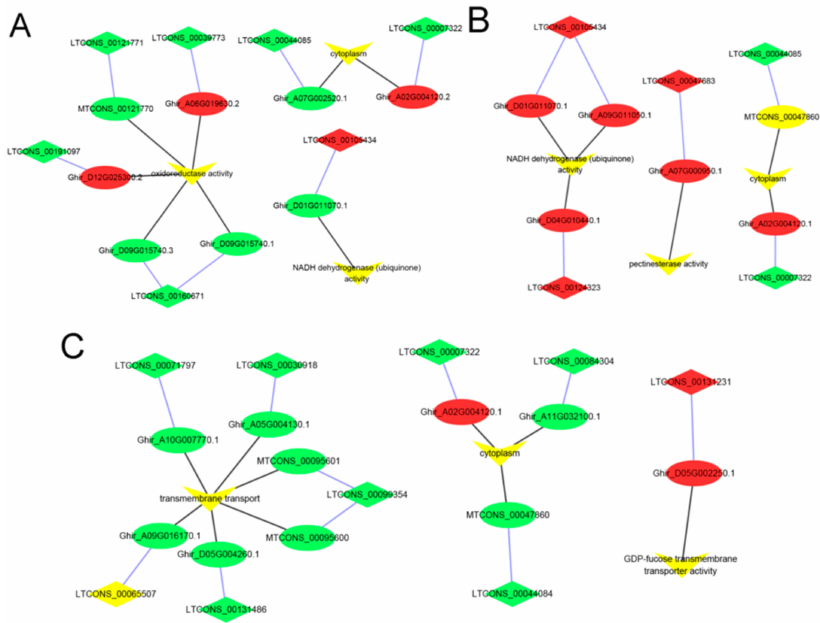
Figure 5. GO analysis enriched for lncRNA–potential cis -target genes of anther development between the cytoplasmic male sterility line C2P5A, and the maintainer line C2P5B. ( A ) GO terms enriched for the Pms stage lncRNAs–mRNAs. ( B ) GO terms enriched for the Tds stage lncRNAs–mRNAs. ( C ) GO terms enriched for the Ms stage lncRNAs–mRNAs. The ellipse, diamond, and inverted triangle nodes represent the mRNAs ( cis -target genes), lncRNAs, and GO terms, respectively. Red represents upregulated, green represents downregulated, and yellow represents the enrichment of the GO terms. The blue edges and black edges show regulatory interactions among cis -target genes and lncRNAs, genes ( cis -target genes and lncRNAs) and GO terms,